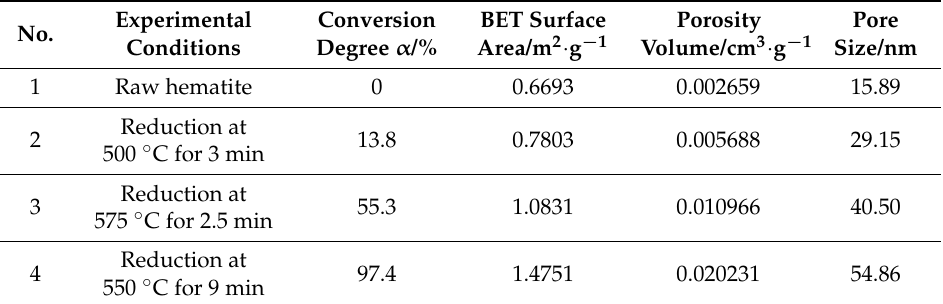
Table 4. Specific surface properties for specimens with different conversion degrees.